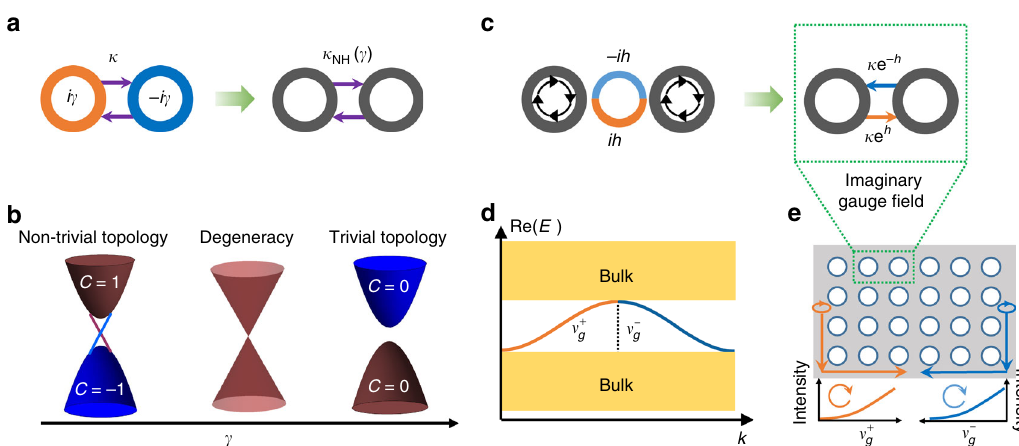
Fig. 2 Novel functionalities from the interplay between optical non-Hermiticity and topological photonics. a shows the unit cell of a coupled resonator array, with hopping rate κ and onsite gain/loss coef fi cient γ , which is equivalent to its Hermitian counterpart with a modi fi ed coupling κ Hermiticity controlled coupling accomplishes the topological phase transition from the trivial to non-trivial band structures via the degeneracy by tuning the gain/loss coef fi cient as shown in ( b ). Here C represents the Chern number related to the bulk band. c shows a typical unit cell of a coupled resonator array subjected to a pseudo-spin-dependent imaginary gauge fi eld engineered by an anti-resonance link ring with gain on the lower half and loss on the upper half. This coupling scheme is equivalent to two site resonators with asymmetric hopping rates: the clockwise circulating light hops from left to right with a rate of exp( h ), while it hops from right to left with a much smaller rate of exp( − h ), where h is the single-pass ampli fi cation/attenuation of the lower/upper halves of the link ring. d shows the topological pseudo-spin subbands, subjected to the imaginary gauge fi eld, containing the amplifying propagation state with forward group velocity v þ (orange curve) and the attenuating propagation state with backward group velocity v (cid:2) g gauge fi eld, only the forward propagation can be observed in real space while the backscattering is absorbed in the link rings, resulting in robust one-way propagation, as shown in ( e